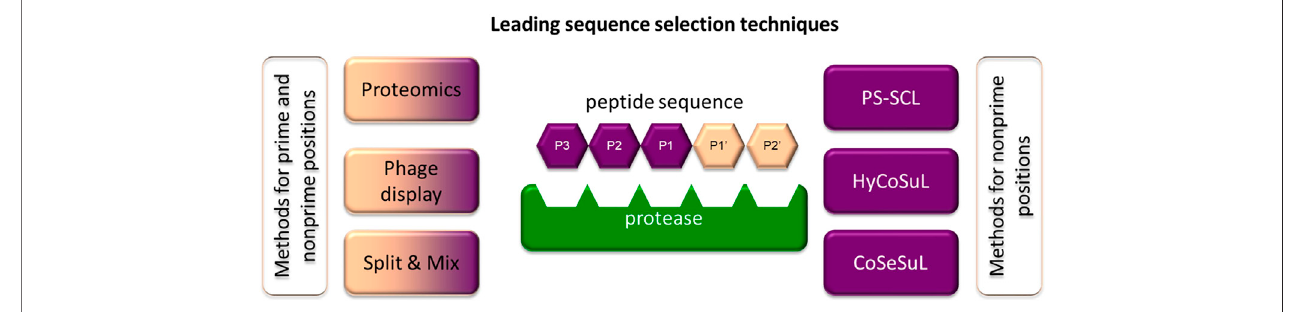
FIGURE6| Methodsfrequentlyappliedtoidentifyspeci fi csequencesforchemicalreagentsforserineproteaseimaging.Someofthetechniquescanbeappliedto investigate prime and nonprime positions.